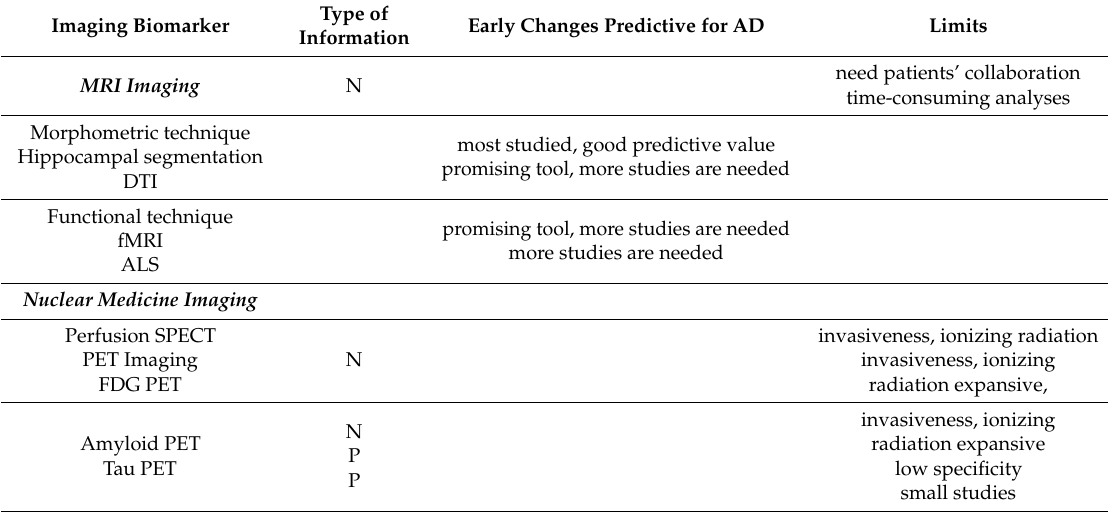
Table 7. Summary of characteristics of main “dry” biomarkers for Alzheimer’s disease. Imaging